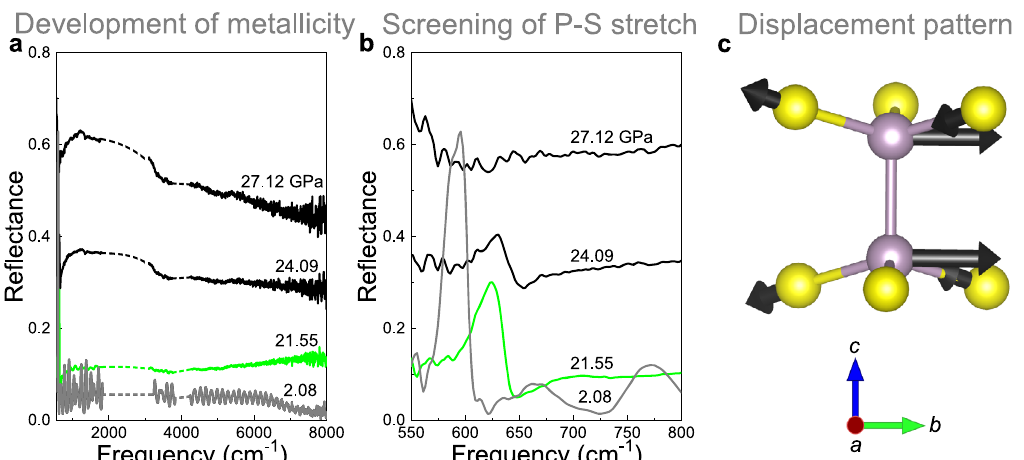
Fig. 2 Insulator-to-metal transition occurs with the development of a Drude response and screening of the phonons. a Re fl ectance of NiPS 3 as a function of frequency showing the development of metallicity under pressure. Dashed lines omit the well-known diamond signature and guide the eye. b Close-up view of the 590 cm − 1 P-S stretch which is increasingly screened by the Drude under pressure, consistent with the development of metallicity. The metallicity develops gradually, in line with transport results 12,15 and consistent with a infrared-active second-order transition. This implies that a group-subgroup symmetry analysis is reasonable. c Calculated displacement pattern of the P-S stretching mode. Phosphorus and sulfur centers are purple and yellow, respectively. Black arrows indicate both direction and magnitude of the